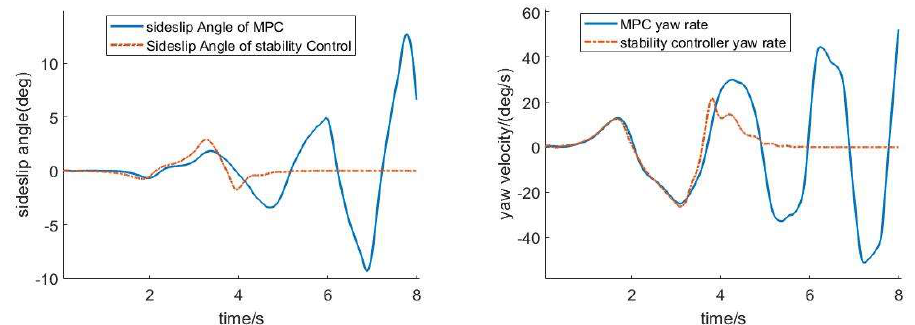
Figure 15. Performance comparison of controllers.